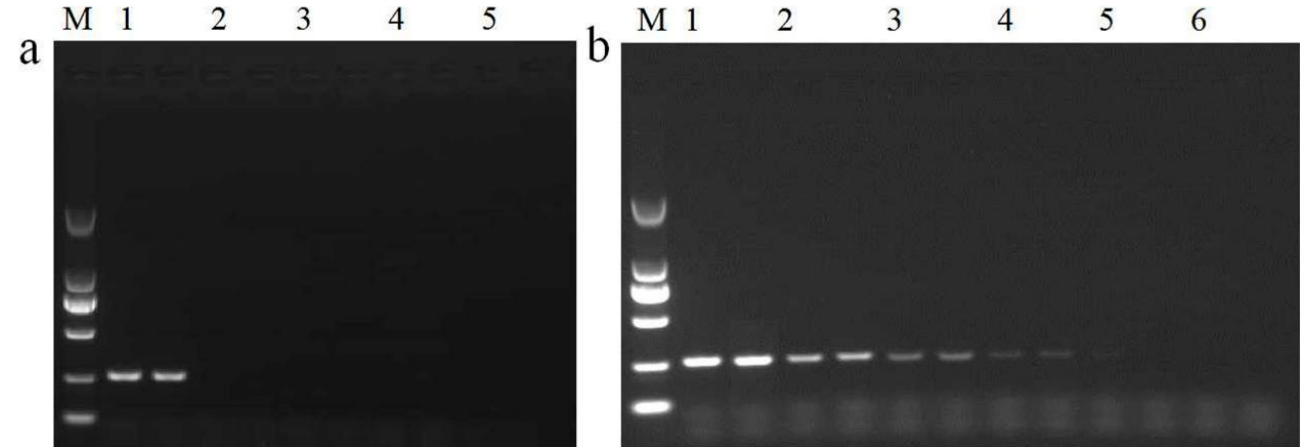
Figure 2. Assessment of the specificity and sensitivity of HPT qualitative PCR detection. ( a ) Testing of the amplification specificity of qualitative PCR. Lane M: DL 2000 DNA Marker. Lane 1: pFP-hpt plasmid, Lane 2: Kefeng6, Lane 3: Kemingdao, Lane 4: SD rice, and Lane 5: no template control; each template was run with two parallel reactions. ( b ) Sensitivity of the qualitative PCR assay. Lane M: DL 2000 DNA Marker. Lanes 1–6 correspond to 500, 100, 50, 20, 10, and 0 copies of pFP-hpt, respec- tively; each template was run with two parallel reactions.